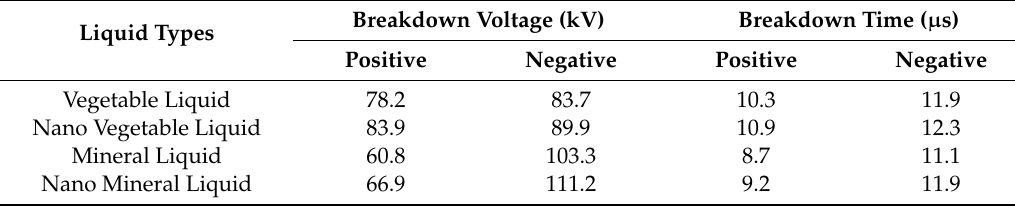
Table 2. Lightning impulse breakdown voltage of insulating liquid.